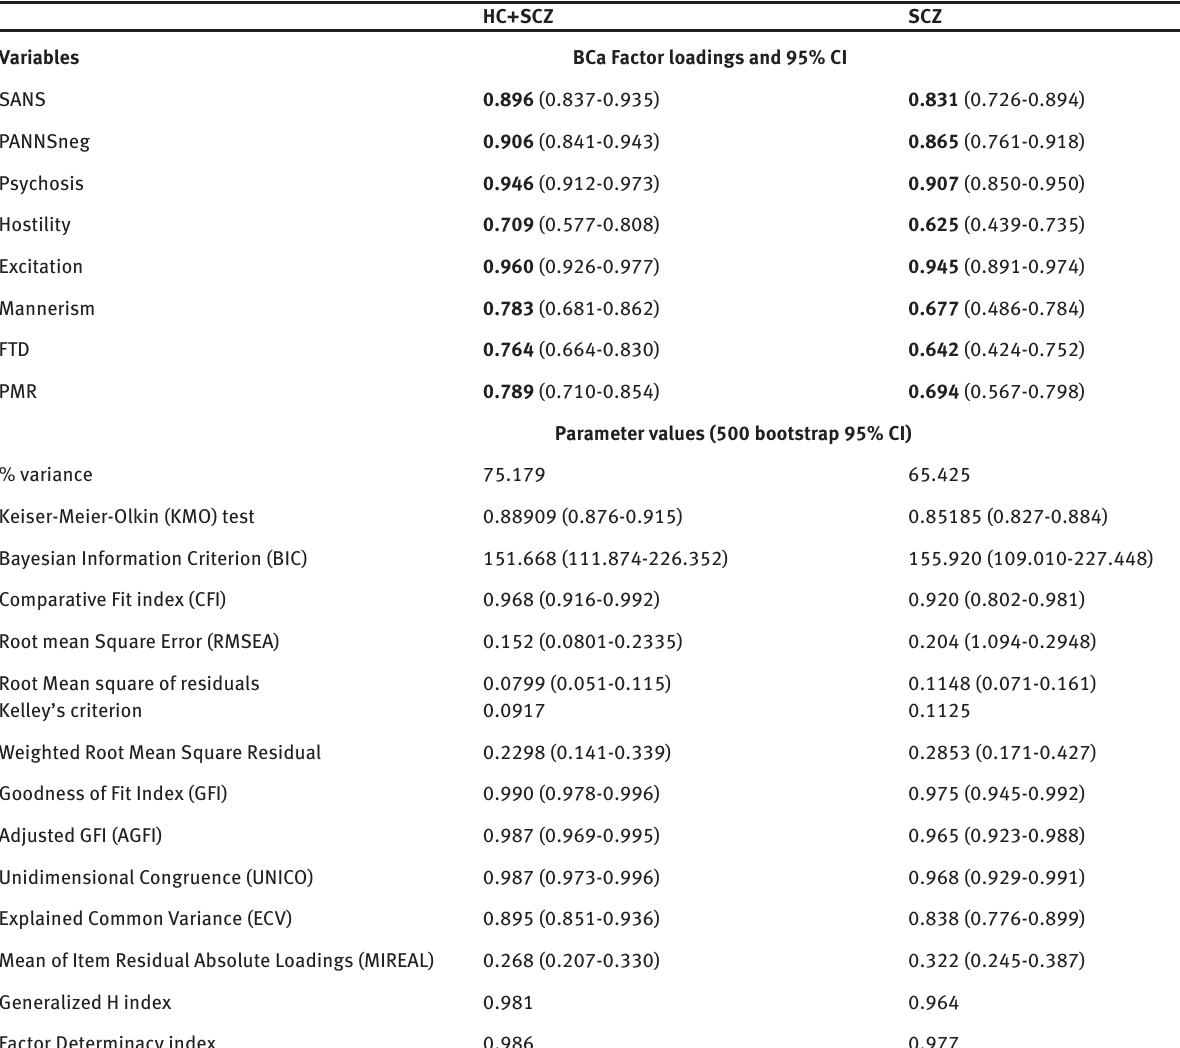
Table 3: Results of Exploratory Factor Analysis (EFA) performed on the eight key symptom dimensions of schizophrenia HC+SCZ